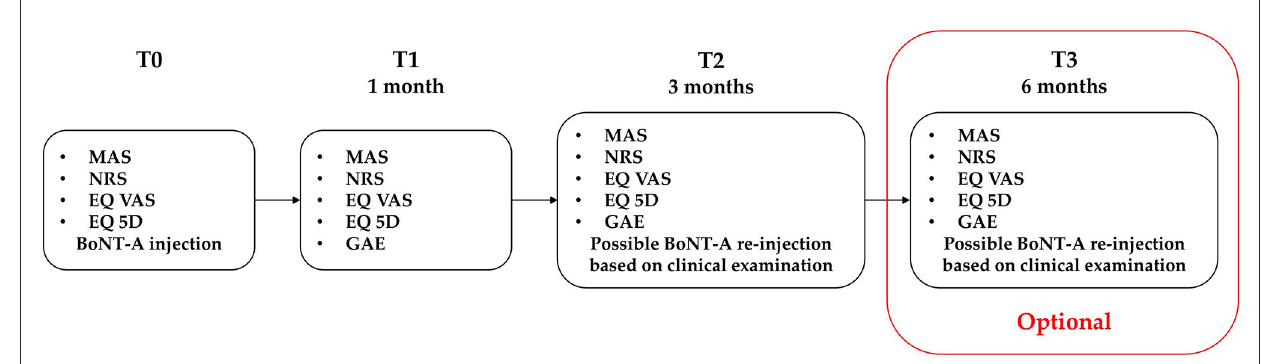
FIGURE1 Study flowchart. MAS, modified Ashworth scale; NRS, numeric rating scale; EQ VAS, European quality of life visual analog scale; EQ 5D, European quality of life 5 dimensions. An optional T3 visit was performed for subjects who did not receive second BoNT-A treatment at